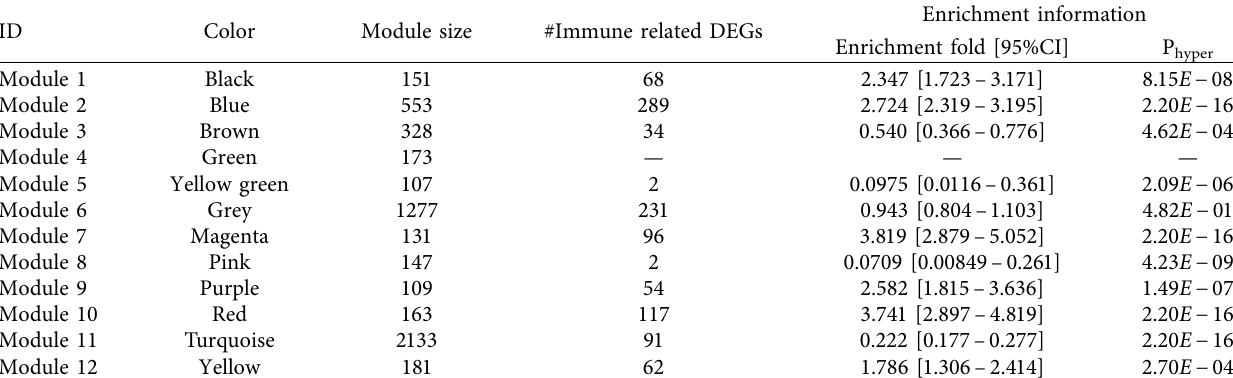
Table 2: After batch effect removal, the two datasets tend to be distributed together. The expression spectrum data of the combined datasets are shown in Table